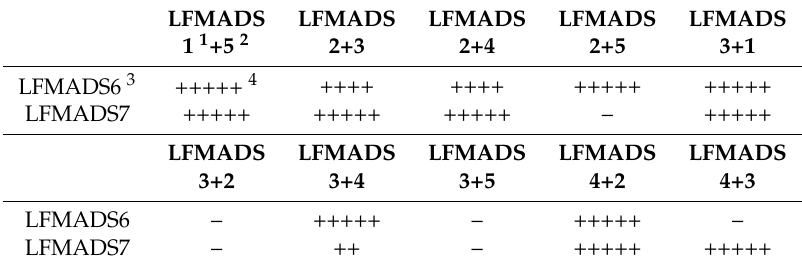
Figure 12. Analysis of protein-protein interactions among B-, C-, D-, and E-class LFMADS proteins by using the GAL4 yeast two-hybrid system. ( A ) Co-transformed yeast cells with two constructs, including GAL4AD-LFMADSs (AD, on the top) and GAL4BD-LFMADSs (BD, on the left). Each transformant was diluted to 10 6 cells and spotted on control medium (SD/–Leu–Trp) and selective medium (SD/–His–Leu–Trp), respectively. ( B ) Co-transformed yeast cells with three constructs, including BD + AD from ( A ) (on the top), and then transformed with another GAL4AD-LFMADSs construct (AD, on the left). Each transformant was diluted to 10 6 cells and spotted on control medium (SD/–Leu–Trp) and selective medium (SD/–His–Leu–Trp), respectively. All yeast cells grew on control medium indicating correct co-transformations. The B-, C-, D-, and E-class LFMADSs are labeled in green, blue, grey, and pink, respectively. Table 5. Analysis of protein–protein interactions between the E-class LFMADSs (LFMADS6 and 7) and other B-, C-, D- class LFMADS proteins performed by GAL4 yeast two-hybrid system.